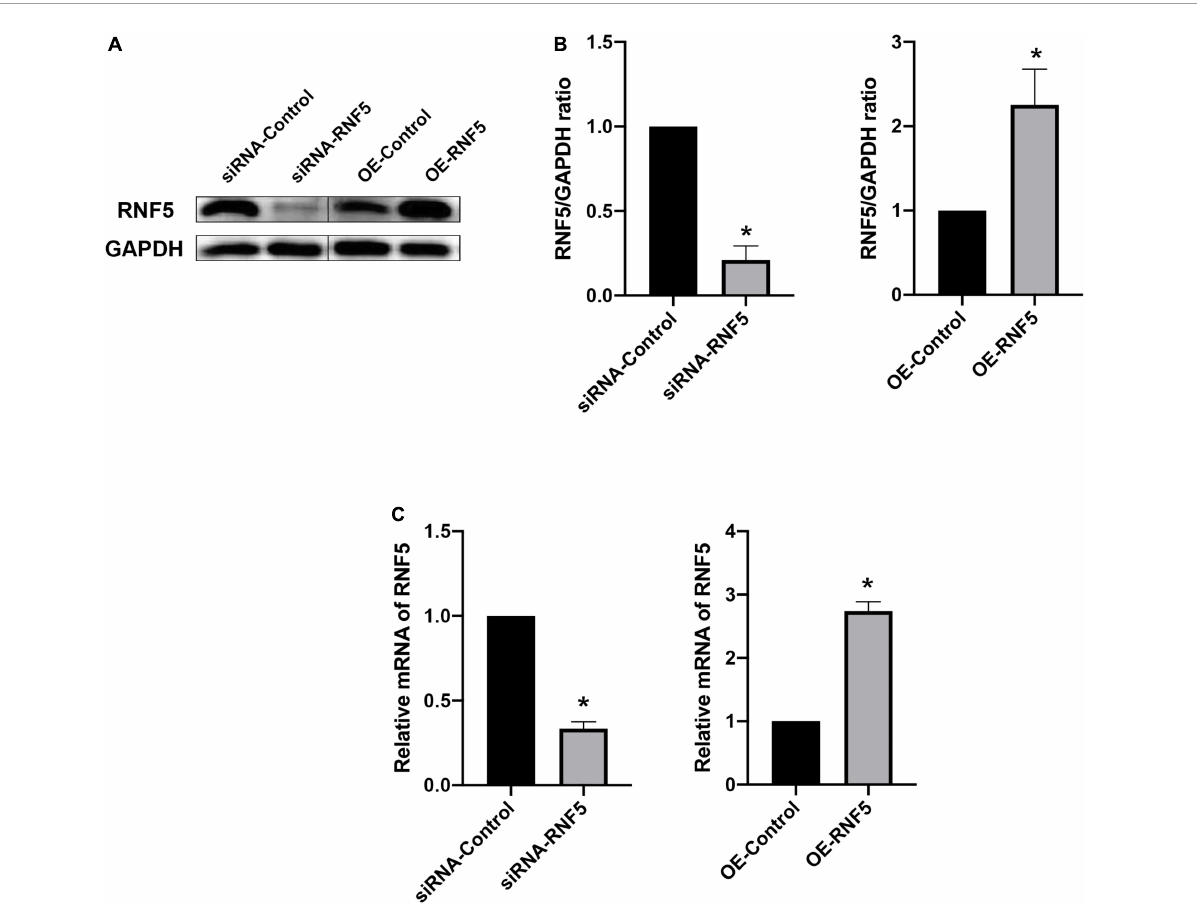
FIGURE2 Silencing and overexpression of RNF5 in HCECs. (A) At 24 h after the transfection of siRNAs and plasmids, the expression of RNF5 in HCECs was detected using Western blotting. (B) Relative gray value statistics, with GAPDH as the internal reference. The left side is the silenced group, and the right side is the overexpression group. The transfection efficiency was as expected. (C) At 24 h after the transfection of siRNAs and plasmids, the expression of RNF5 mRNA was detected, with GAPDH as the internal reference. Data are shown as mean ± SD of three independent experiments. * P <